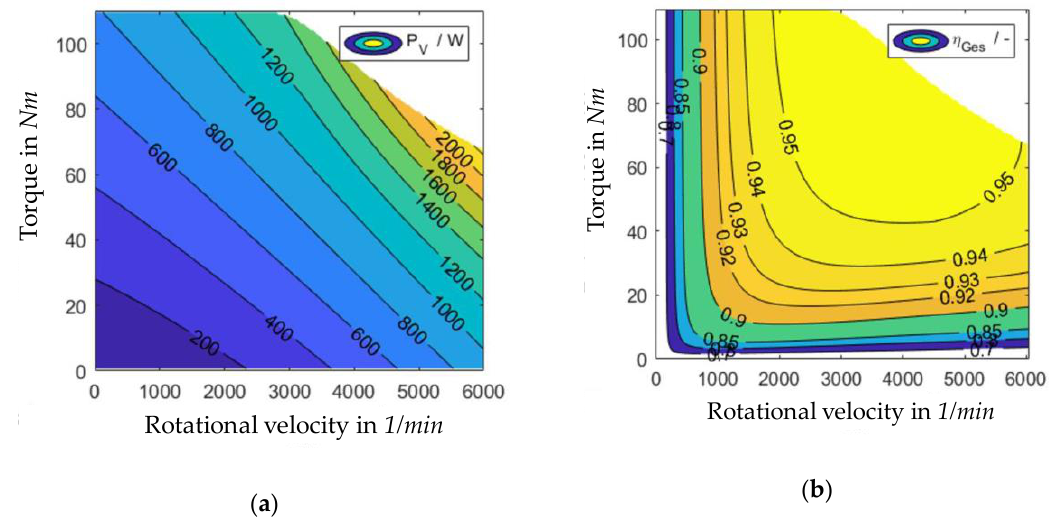
ffi ciency diagram of an electric machine